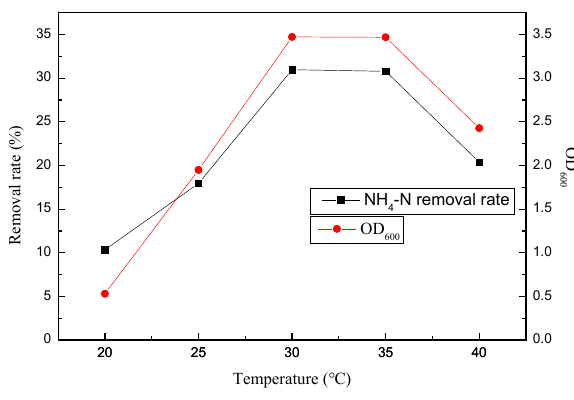
-N removal and OD 4